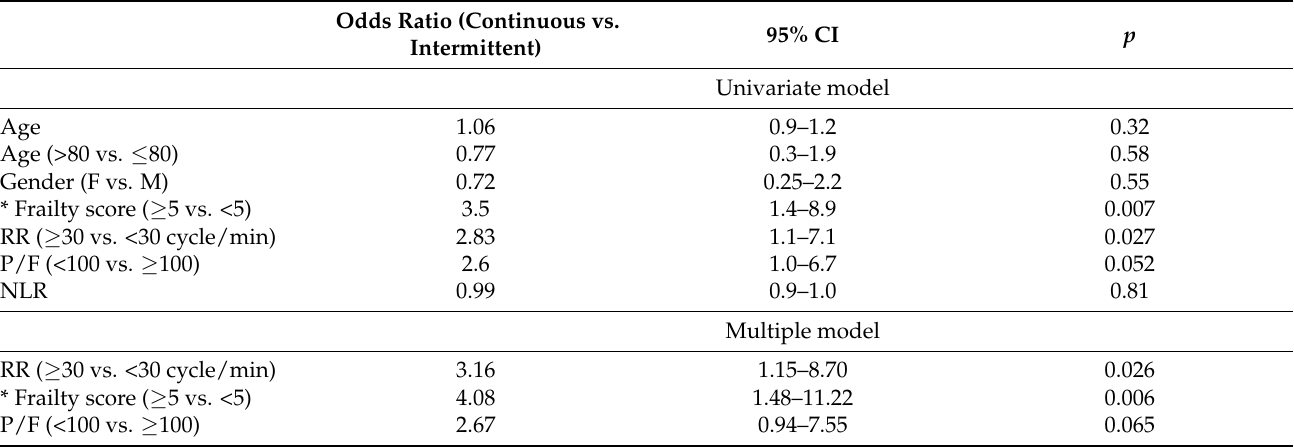
Table 2. Univariate and multiple logistic regression analyses by baseline characteristics. Dependent variable: type of CPAP demand at